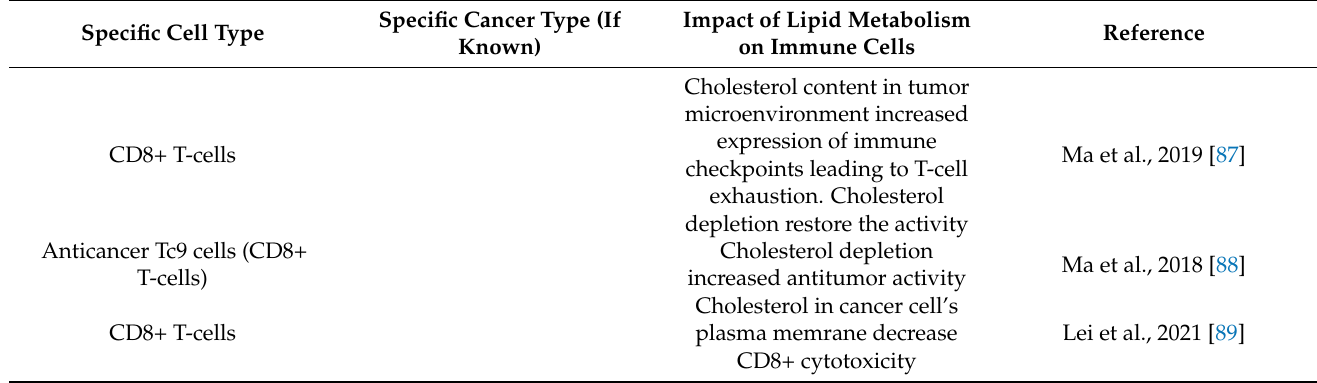
Table 1. Summary of published studies on changes in the lipidome and cholesterol metabolism in cancer-associated immune